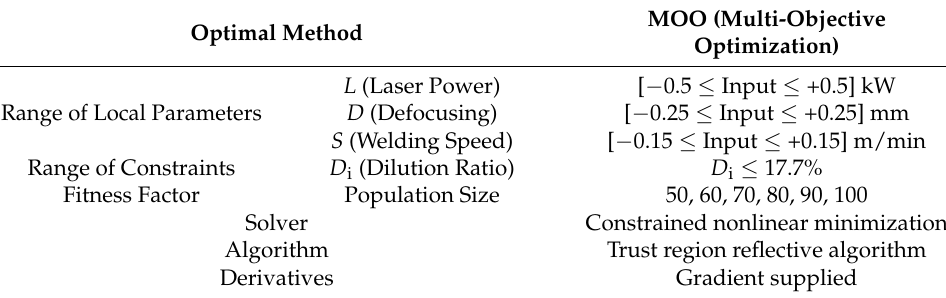
Figure 10. Flow chart of the multi-objective optimization (MOO) method to predict the welding parameters. Table 12. MOO algorithm parameters and their values.